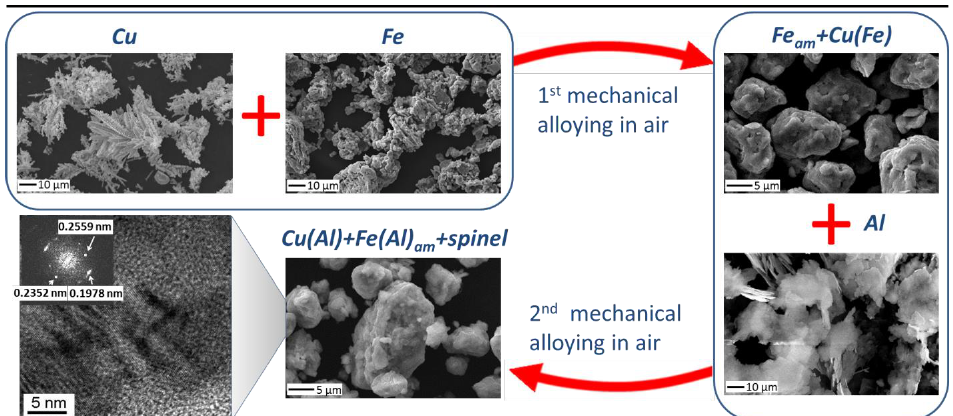
Figure 1. Scheme of the preparation